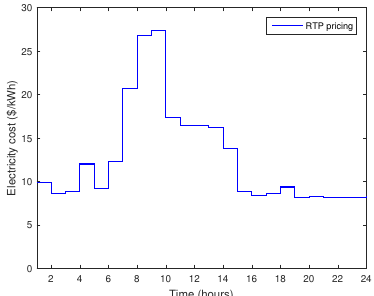
Figure 7. Real time price (RTP) pricing signal obtained from